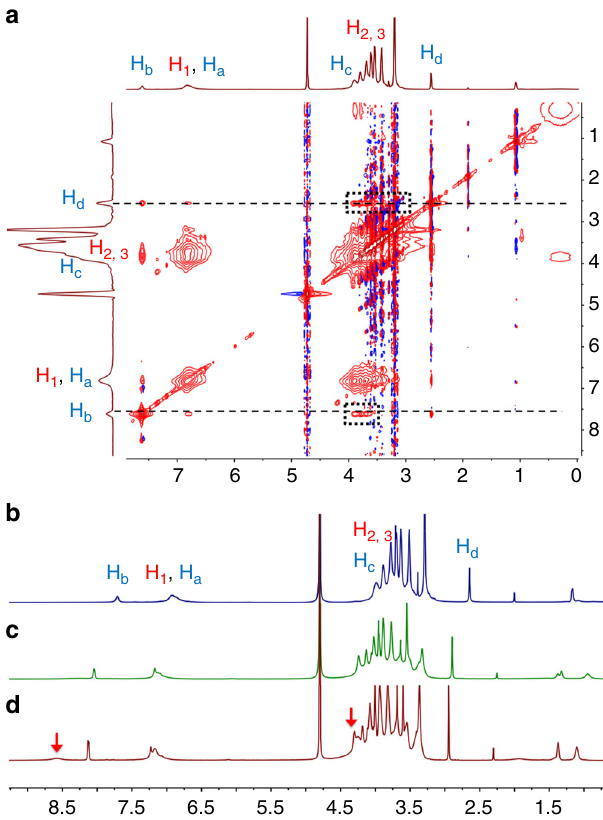
Fig. 2 Study of host − guest interactions at various temperatures. a 2D NOESY spectrum (400MHz, D 2 O) of G1 + P5 (5.00mM). The correlation signals between the host and guest were marked with rectangles. 1 H NMR spectra (400MHz, D 2 O) of G1 + P5 (5mM) at b 25°C, c 45°C, and d 50°C. Peaks belonging to de-threaded guest are marked with red arrows in